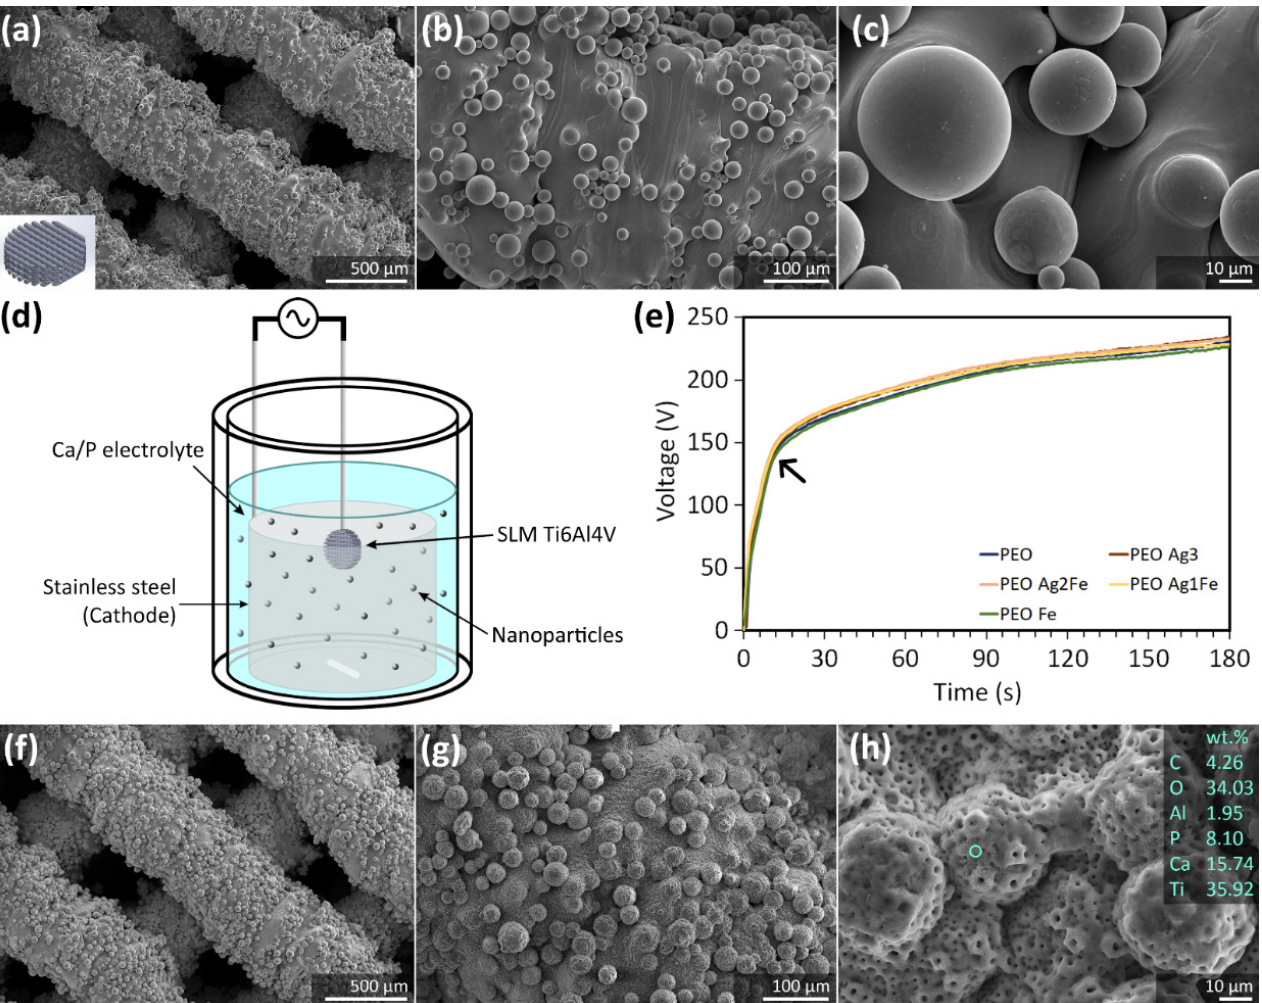
Figure 1. ( a – c ) The surface morphology of selective-laser-melted Ti6Al4V scaffolds at different mag- nifications, imaged using SEM. ( d ) An illustration of the PEO setup with the titanium scaffold and the stainless steel cathode in the Ca/P-containing electrolyte doped with NPs for surface biofunc- tionalization. ( e ) The V-t transients were recorded during the surface biofunctionalization of the titanium scaffolds using the electrolytes containing Fe NPs and Ag NPs of varying concentrations. biofunctionalization were imaged at different magnifications using SEM and analyzed with EDS.